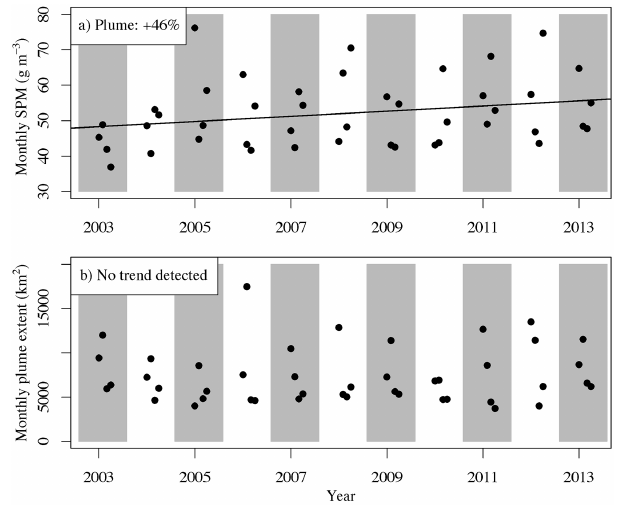
Figure 11. Multiyear (2003–2013) trends in the variation in the monthly-averaged SPM concentration in the Mackenzie River plume (a) and extent of the river plume (b)